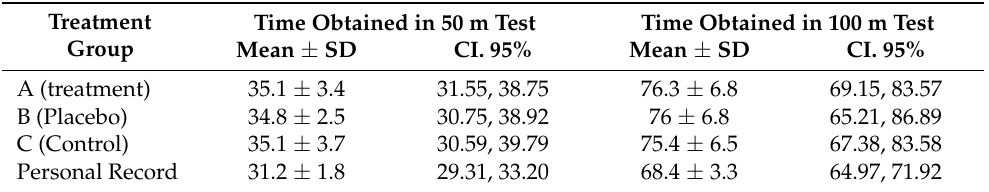
Table 4. Mean ± standard deviation of the time for different distances and respective confi- dence